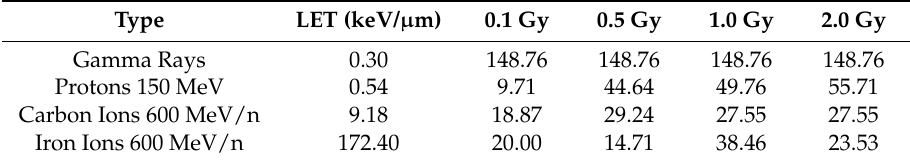
Table 1. Dosage rate (cGy/min) for different radiation